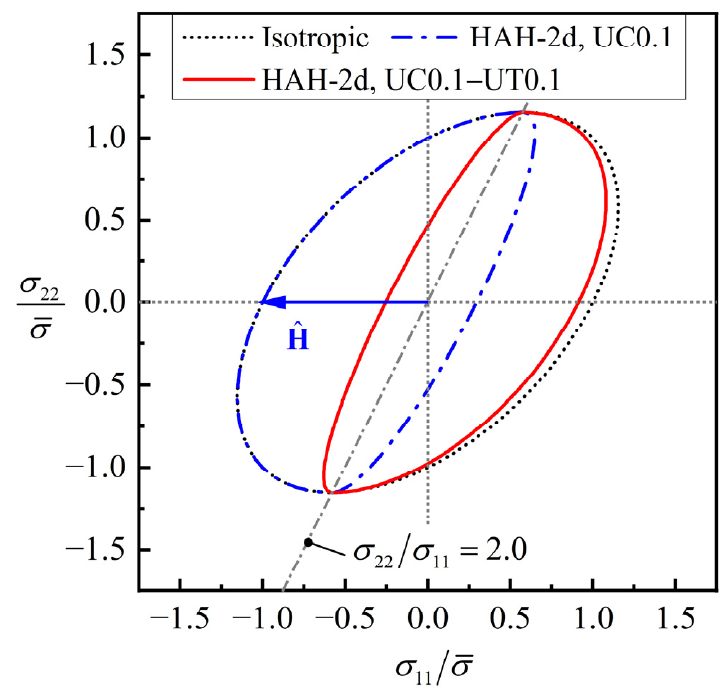
Figure 4. Evolution of the normalized yield locus of the generic material predicted by the HAH-2d model in a uniaxial compression-tension loading path.